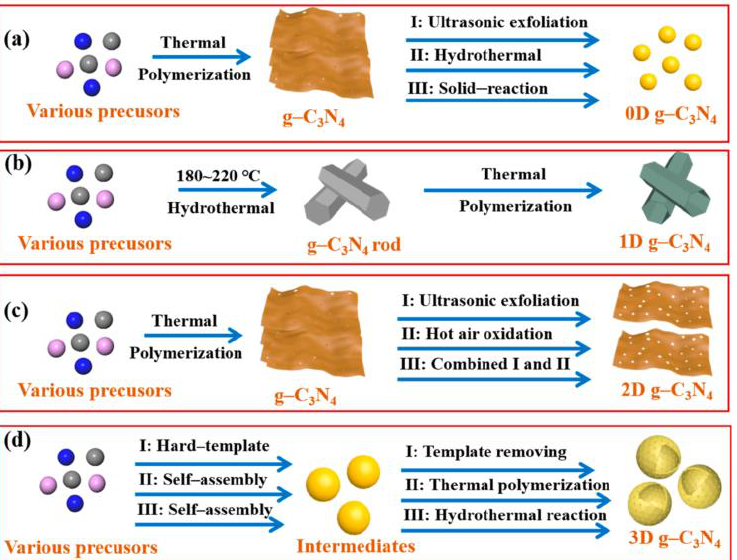
Figure 3. Schematic illustration of different techniques for the synthesis of ( a ) 0D g-C 3 N 4 , ( b ) 1D g-C 3 N 4 , ( c ) 2D g-C 3 N 4 , and ( d ) 3D g-C 3 N 4 . Reprinted with permission from Ref. [25] . Copyright 2021 American Chemical Society.